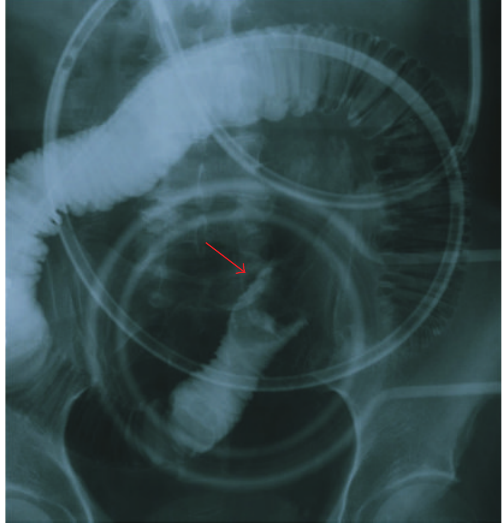
Figure 1: Contrast examination of the ileus tube shows total ob- struction of the ileum by the mass.